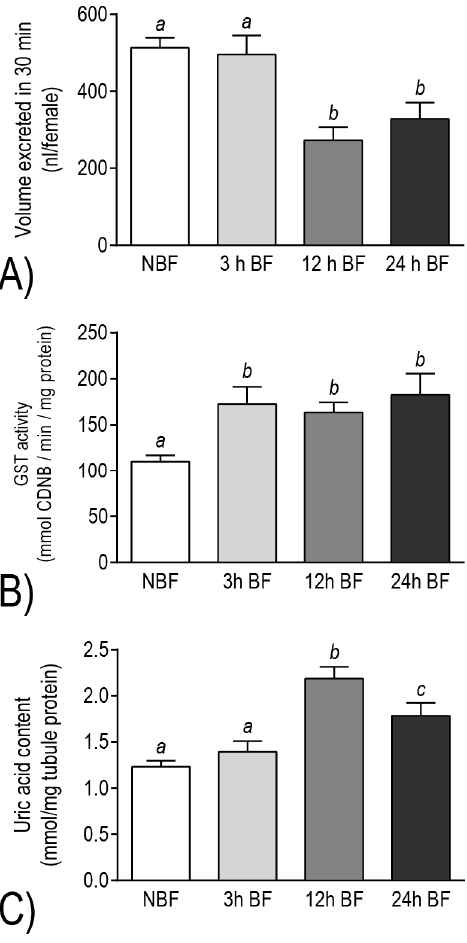
Figure 9. Physiological and biochemical evidence for a functional transition in Malpighian tubules of adult female Ae. albopictus within 24 h after a blood meal. ( A ) Effect of a blood meal on the whole mosquito diuretic capacity. The hemolymph of mosquitoes was microinjected with 900 nl of PBS and the amount of urine excreted was measured 30 min after injection. ( B ) Effect of a blood meal on the biochemical activity of glutathione S -transferase (GST) in Malpighian tubules. The assay measured the GST-mediated conjugation of reduced glutathione to 1-chloro-2,4-dinitrobenzene (CDNB), a colorimetric substrate. ( C ) Effect of a blood meal on the amount of uric acid in Malpighian tubules. In all panels: NBF = non-blood fed mosquitoes and BF = blood fed mosquitoes; values are means ± SEM; and lowercase letters indicate statistical categorization of the means as determined by a one-way ANOVA with a Newman-Keuls posttest ( p < 0.05). Modified from [12].